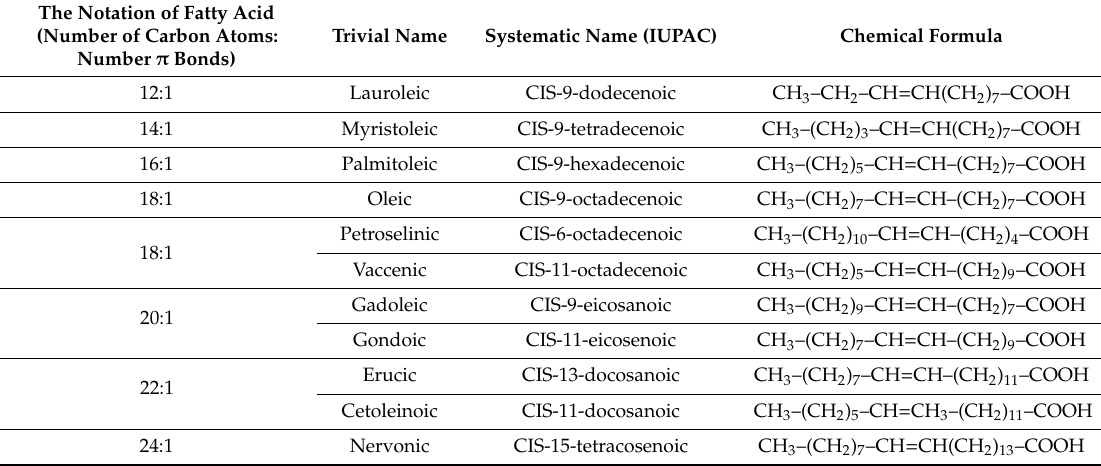
Table 2. The most common monounsaturated fatty